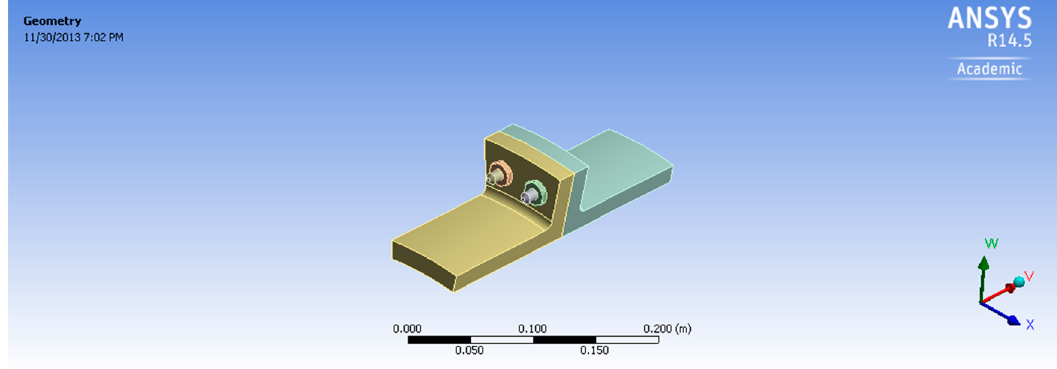
Figure 1. Two bolts were used to simulate the preloaded bolted joint of the